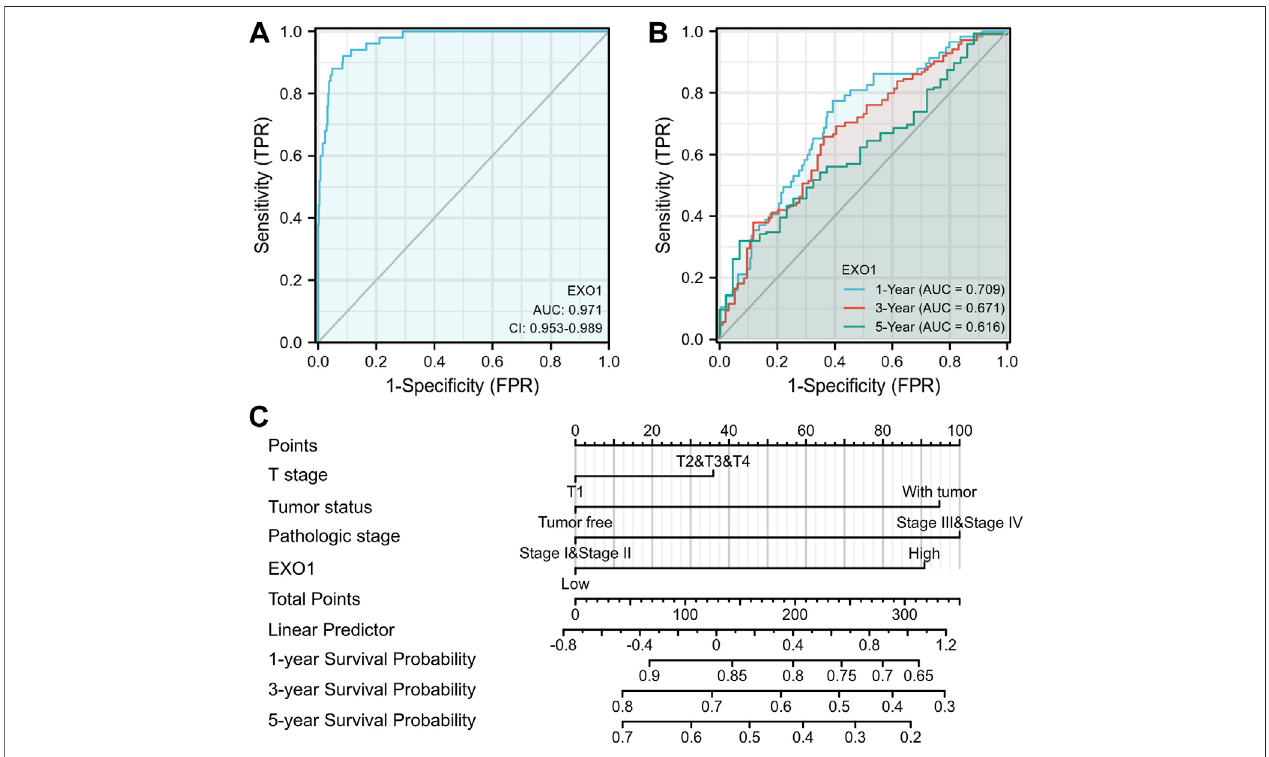
FIGURE 9 | The nomogram model with EXO1 shows a superior diagnostic and prognostic performance in HCC. (A) Diagnostic ROC curves to distinguish HCC tissues and normal tissues based on the EXO1 expression levels. (B) Time-dependent survival ROC curves to predict 1-, 3-, and 5-year survival rates of HCC patients based on the EXO1 expression levels. (C) ROC curve analysis to evaluate the prediction ef fi cacy of the nomogram model that includes clinicopathological factors (T stages, tumor status, and pathologic stages) and EXO1 expression levels to predict the 1-, 3-, and 5-year survival rates of HCC patients.